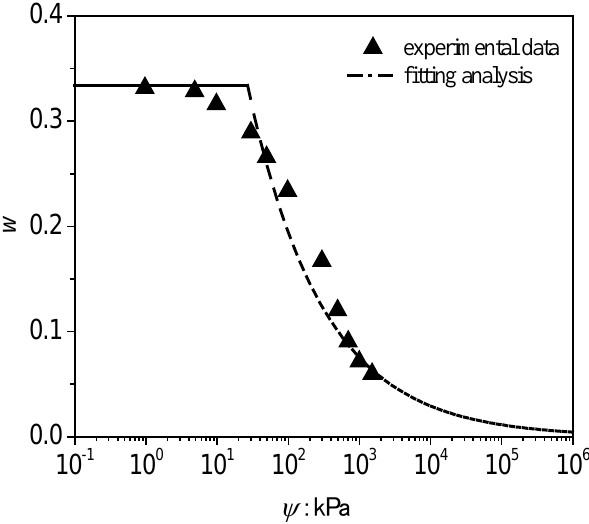
Figure 10. Determination of air-entry values at reference state through fitting Equation (12) to the experimental SWCCs for Guangxi expansive soil with e 0 = 0.901.